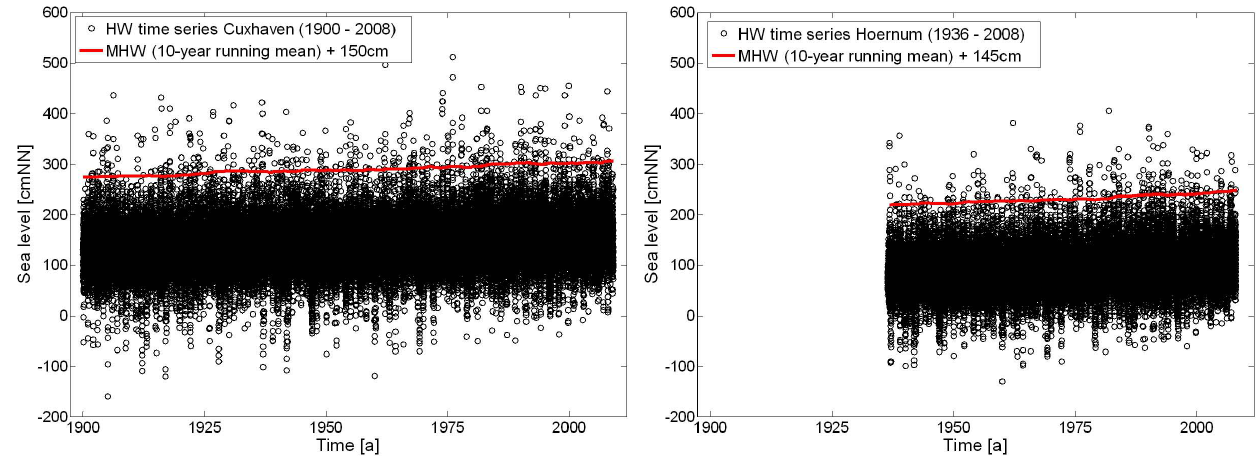
Fig. 4. Tidal high water (HW) time series for Cuxhaven (left) and H ¨ ornum (right) with the estimated threshold time series.